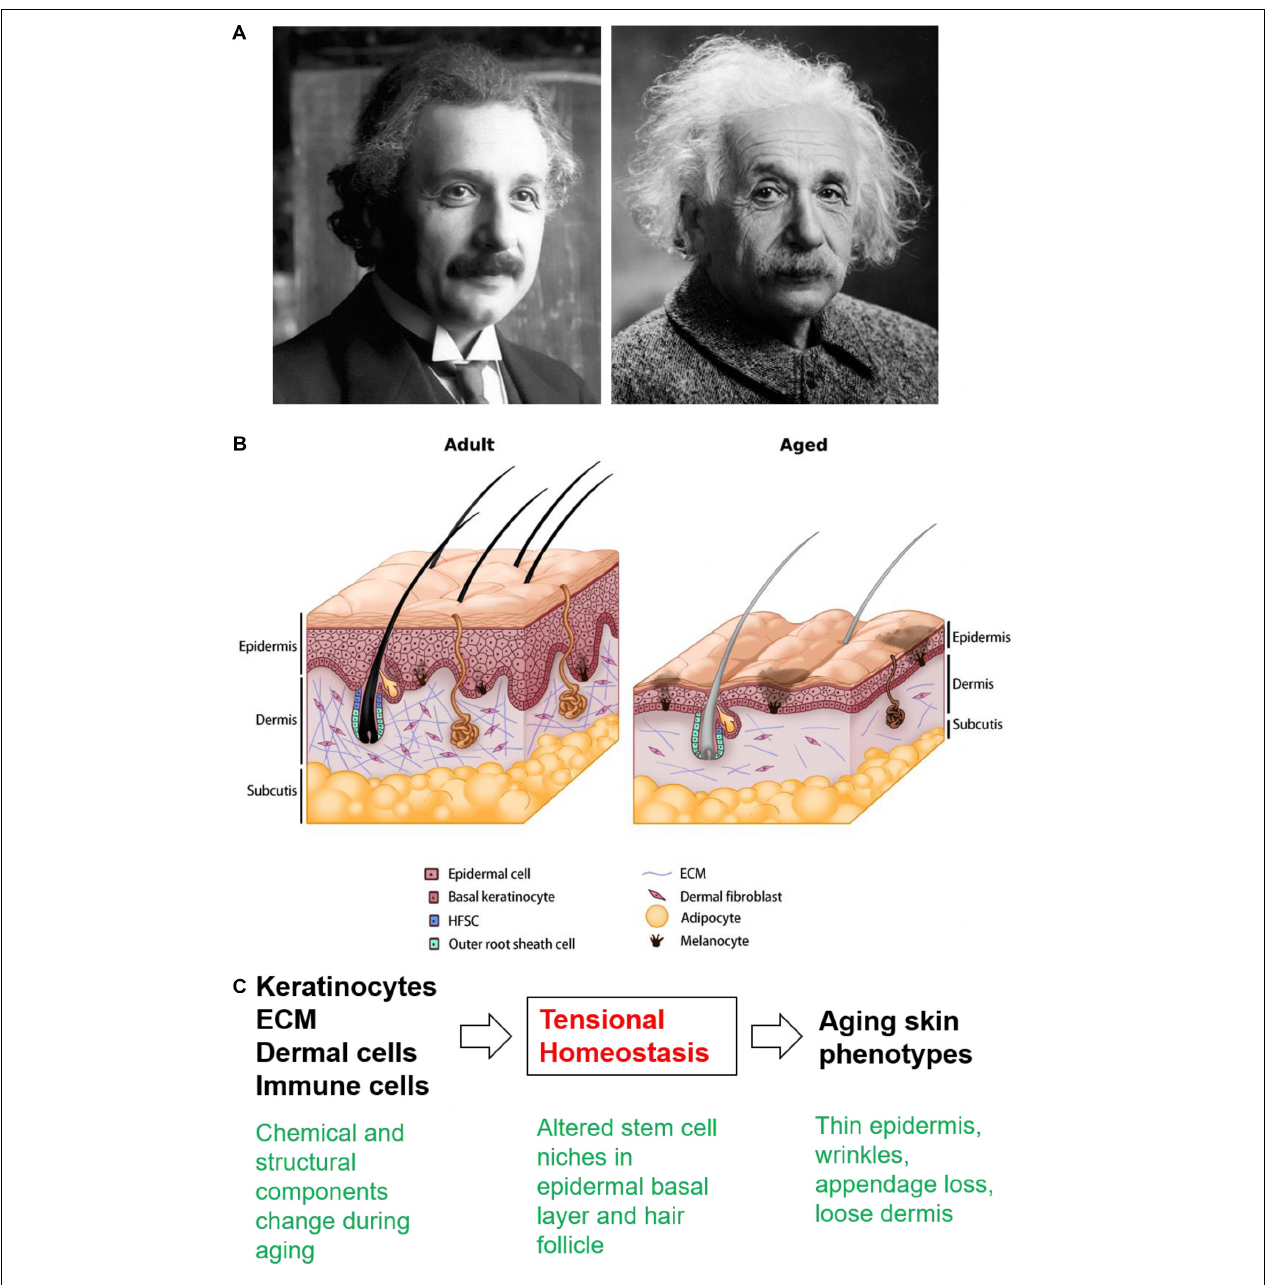
FIGURE 1 | The aging skin. (A) Young and old Albert Einstein used to illustrate the changes in the appearance of aging skin. Source: Pixabay. (B) Schematic drawing showing skin architecture in the adult and aged skin. In aged skin, the overall thickness decreases progressively across all layers, accompanied by wrinkles, pigmentary changes, loss of underlying fat, hair graying, hair loss, and decreased sebaceous gland function. The reduced number and altered activity of fibroblasts have been implicated as the underlying cause of decreased dermal ECM synthesis, leading to deranged ECM support and affects collagen fibril crosslinking. The changes in decreasing cell numbers and altered ECM production and assembly also contribute to hair follicle miniaturization and lowered hair density in aged skin. (C) Cellular/molecular events reviewed in the text present potential new therapeutic